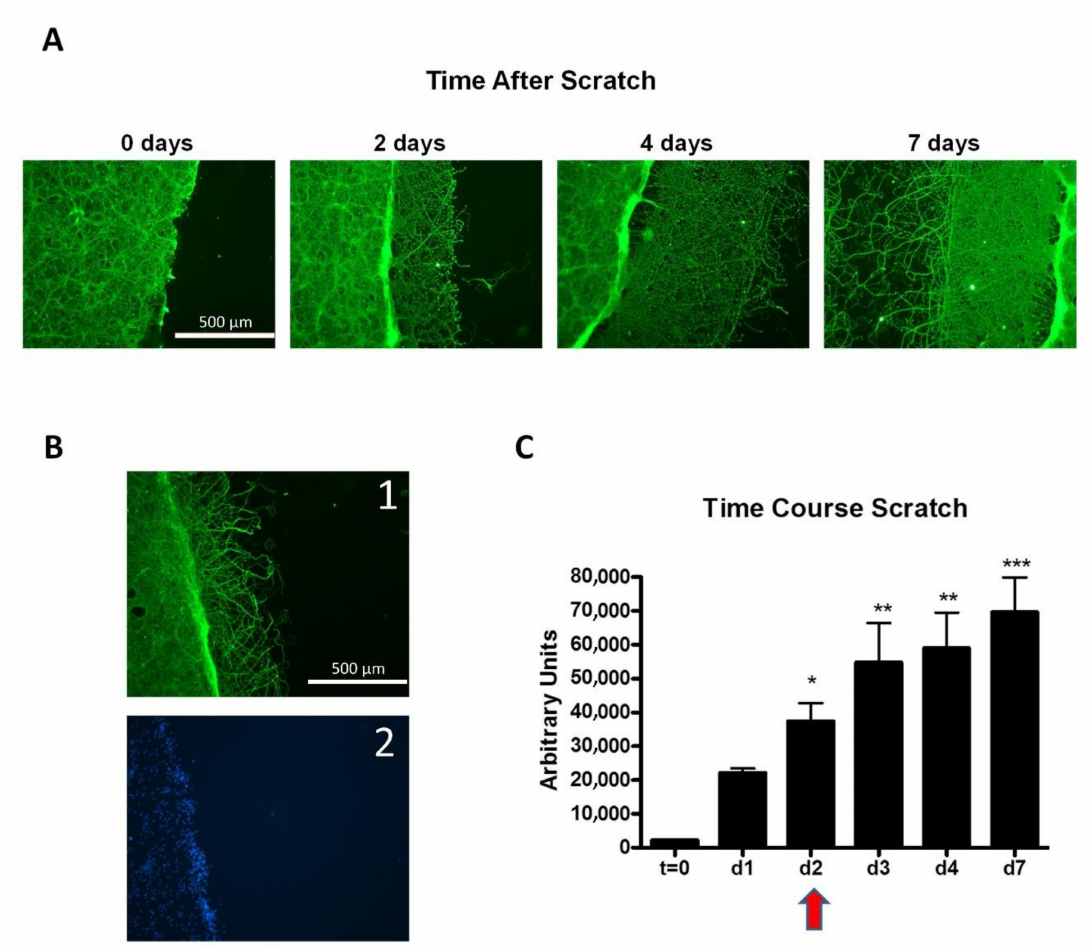
Figure 13. Spontaneous regeneration of an in vitro “wound like” scratch in neural cell cultures over IrO x -eG hybrid. ( A ) Tau imunostaining of scratched cortical neuron cultures showing spontaneous regeneration of surface covered by new neurites after scratching the neuronal monolayer at 5 DIV. ( B1 ) Neurite and ( B2 ) nuclei images for comparison (Cells were processed for Tau inmunocitochemistry and Bis-benzimide staining of the nuclei). ( C ) Quantitative integration of the area covered by new neurites at different days after scratch. Results are mean ± sem (n = 5). * p < 0.05; ** p < 0.01, *** p < 0.001 vs. t = 0 after significant one-way ANOVA. Electric field application would be carried out in a zone where a more drastic change is seen for growth (d2, marked in the red arrow)